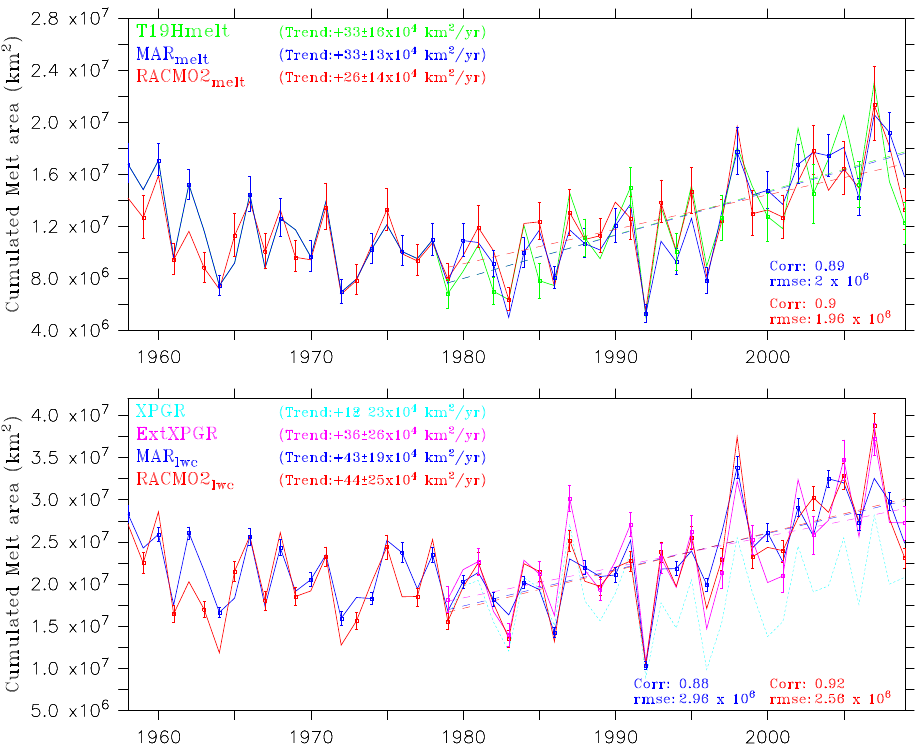
Fig. 8. Time evolution of the annual cumulated GrIS melt area simulated by the RCMs and retrieved from the spaceborne passive microwave data set with the different techniques discussed in the text (see 2). The cumulated melt area is defined as the annual total sum of every daily ice sheet melt area. The linear trend (dashed line) as well as the error bars (see Table 2) are also shown. The uncertainty range of the trend denotes three standard deviations of the trend i.e. a significance of 99%.